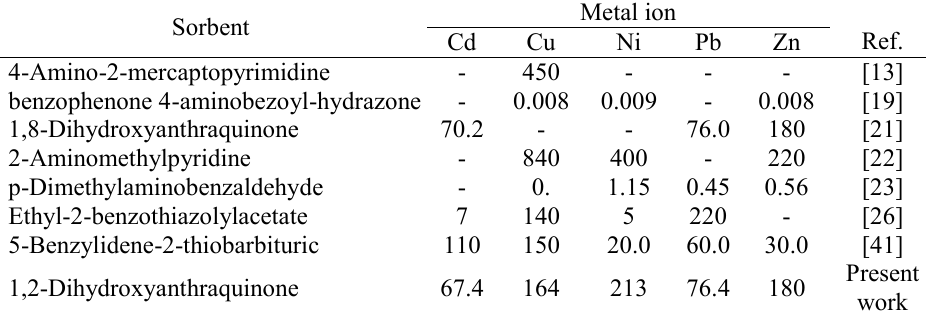
Table 5. Comparison of sorption capacities (  mol/g).